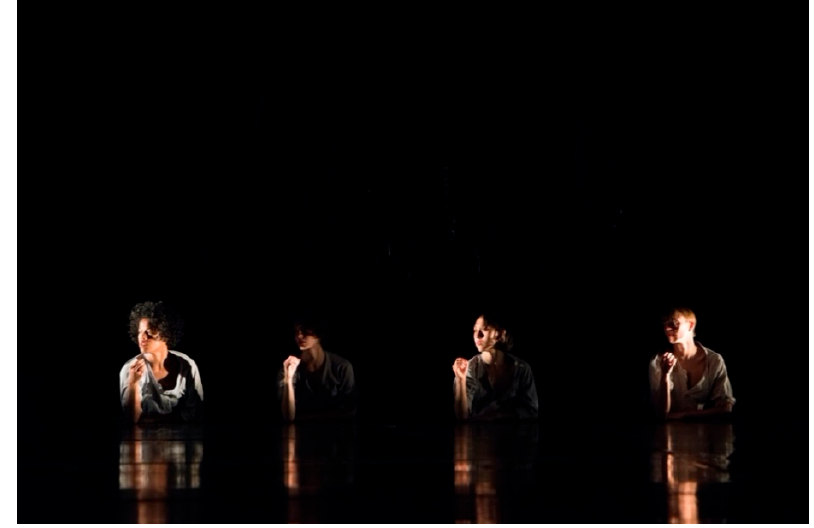
Figure 4. Rosas danst Rosas (2017) Anne Teresa De Keersmaeker/Rosas @ Anne van Aerschot. Used with permission.